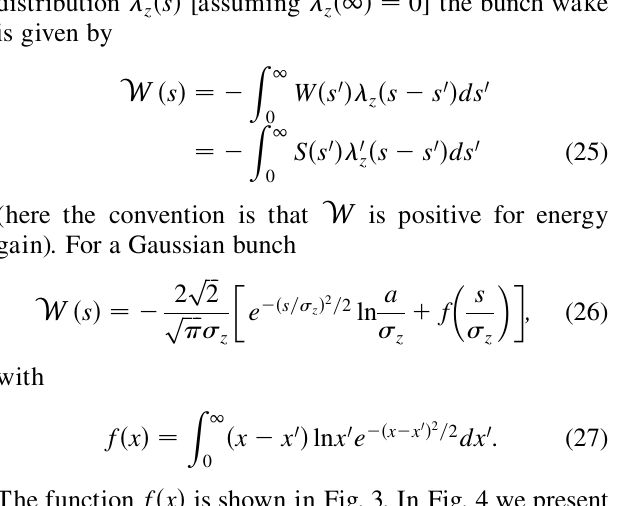
(cid:9) s (cid:10) for z W